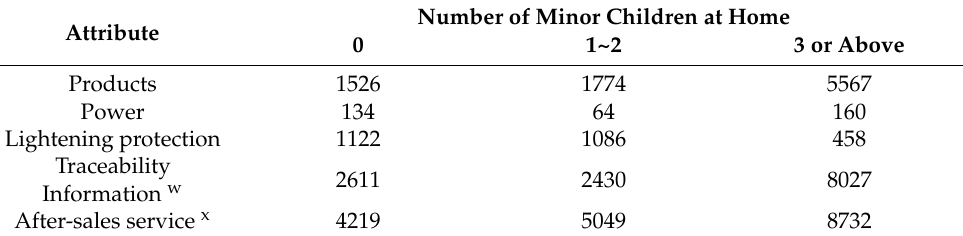
Table 13. Calculated WTP values by number of minor children at home